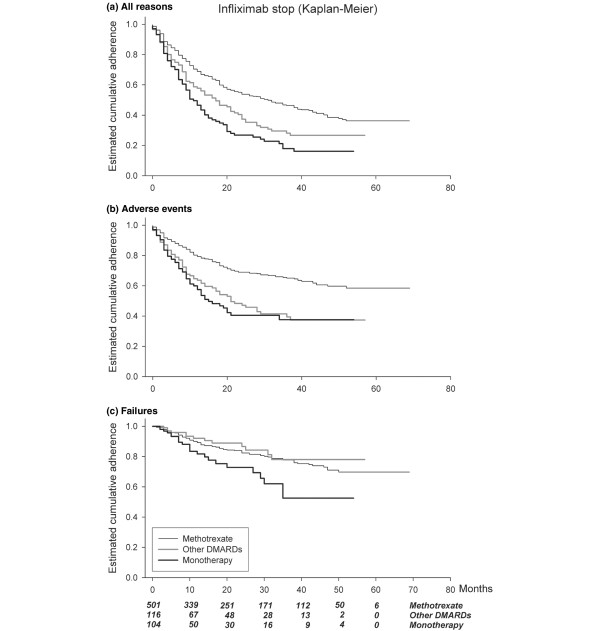
Adherence to therapy for patients treated with infliximab. The level of adherence to therapy is shown as the fraction (between 1 and 0) of patients remaining on therapy during the observation period. Withdrawal due to any reason (a), adverse events (b), or failure to treatment (c) is presented separately. The number of patients under observation at each time point is listed at the bottom of the figure. DMARD, disease-modifying antirheumatic drug.